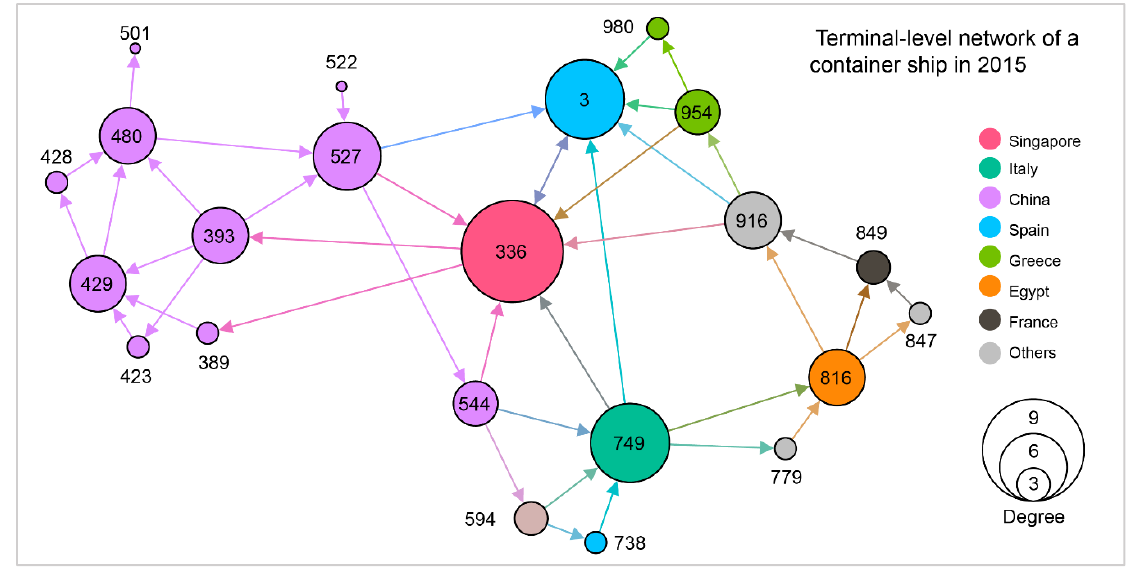
Figure 6. Port-level network of a container ship with 19 nodes located in 11 countries in 2015.